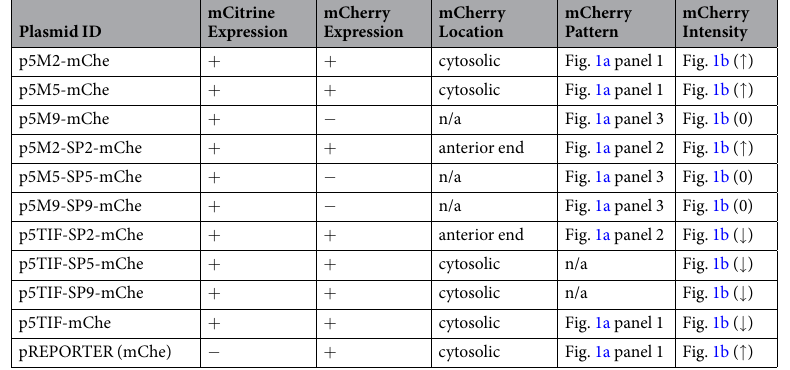
Table 1. Summary of fluorescence profiles of the sporozoites transfected with different plasmid